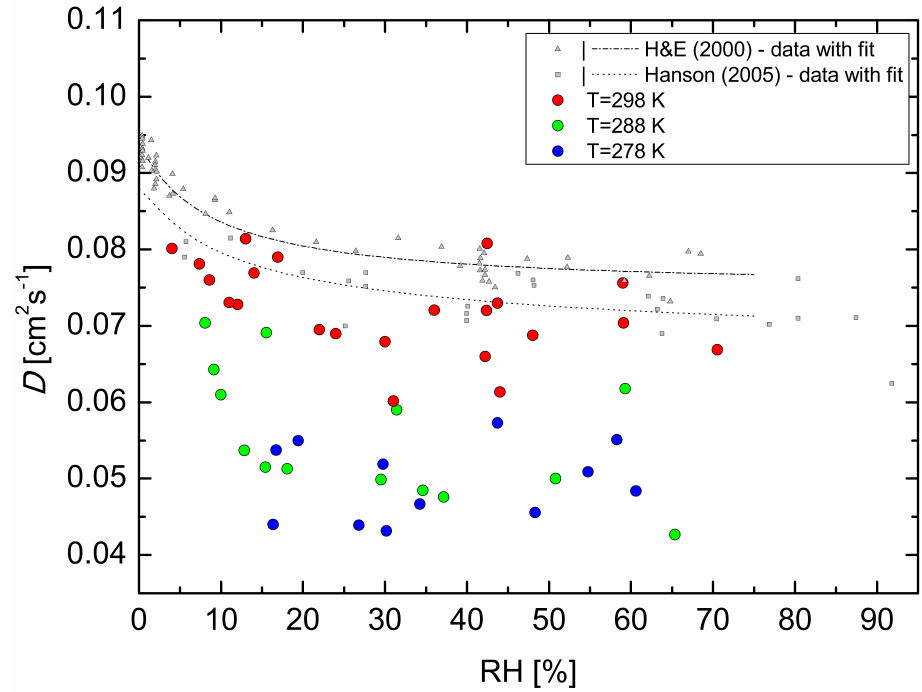
Figure 3. Experimental diffusion coefficient of H 2 SO 4 in air as a function of relative humidity at different temperatures compared with the data of Hanson and Eisele (2000) [6] at 298 K and Hanson (2005) [20] at 295 K of H 2 SO 4 diffusion in N 2 .